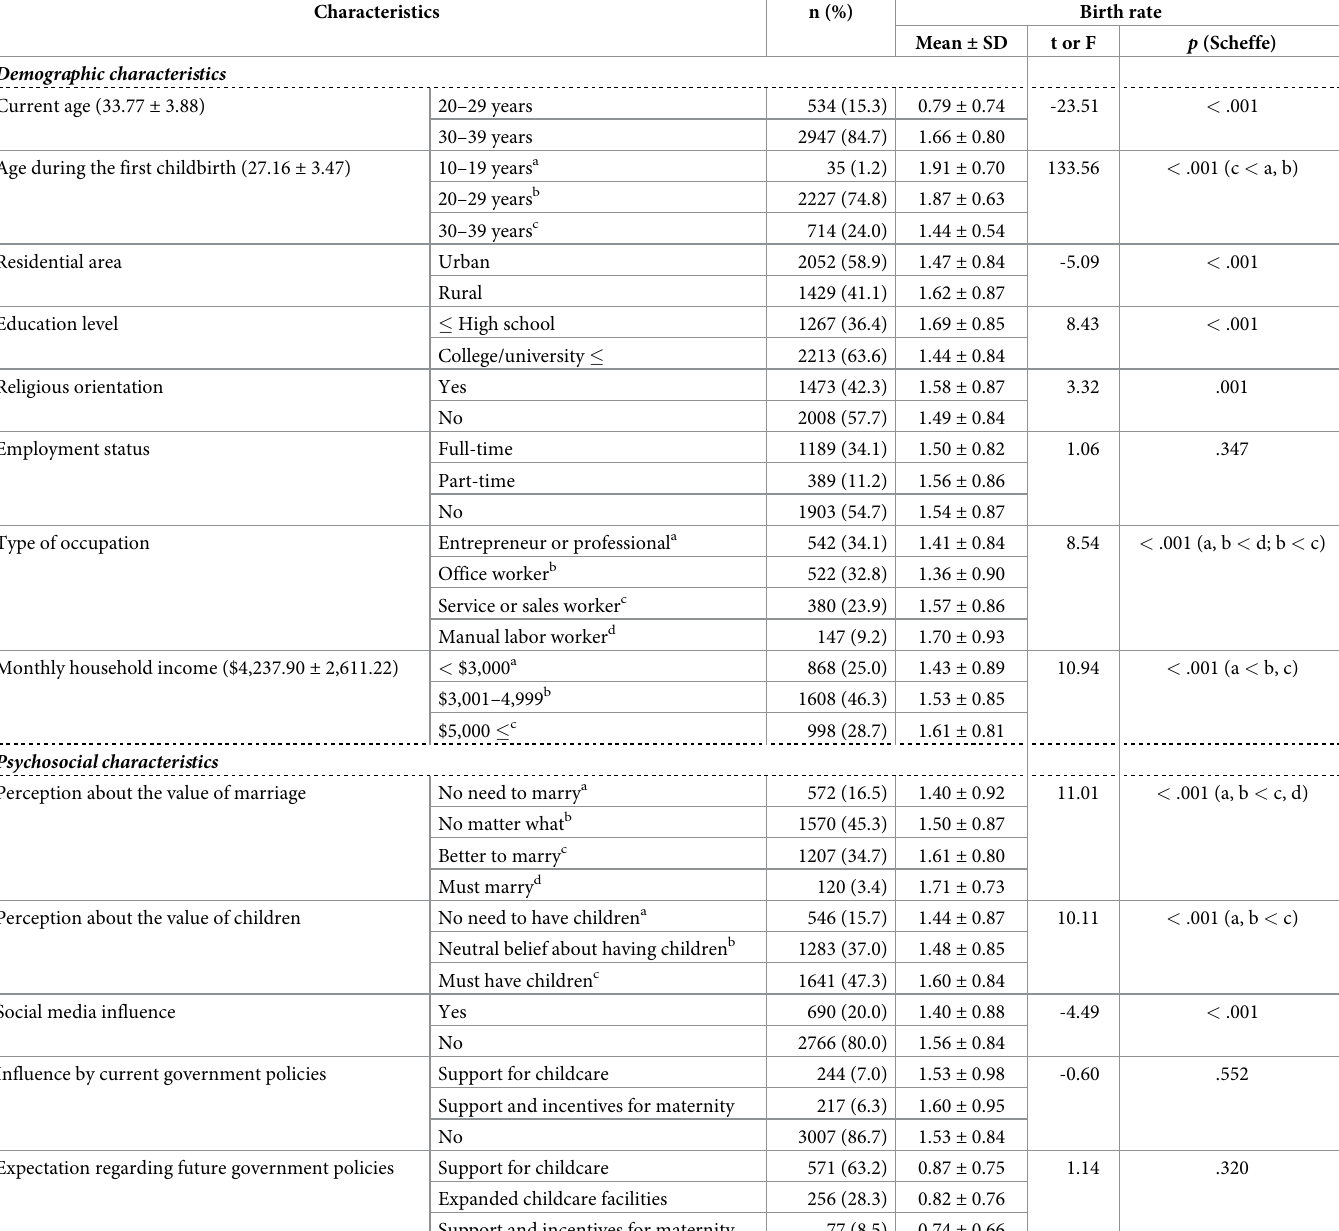
Table 1. Differences in birth rate according to women’s characteristics (N =